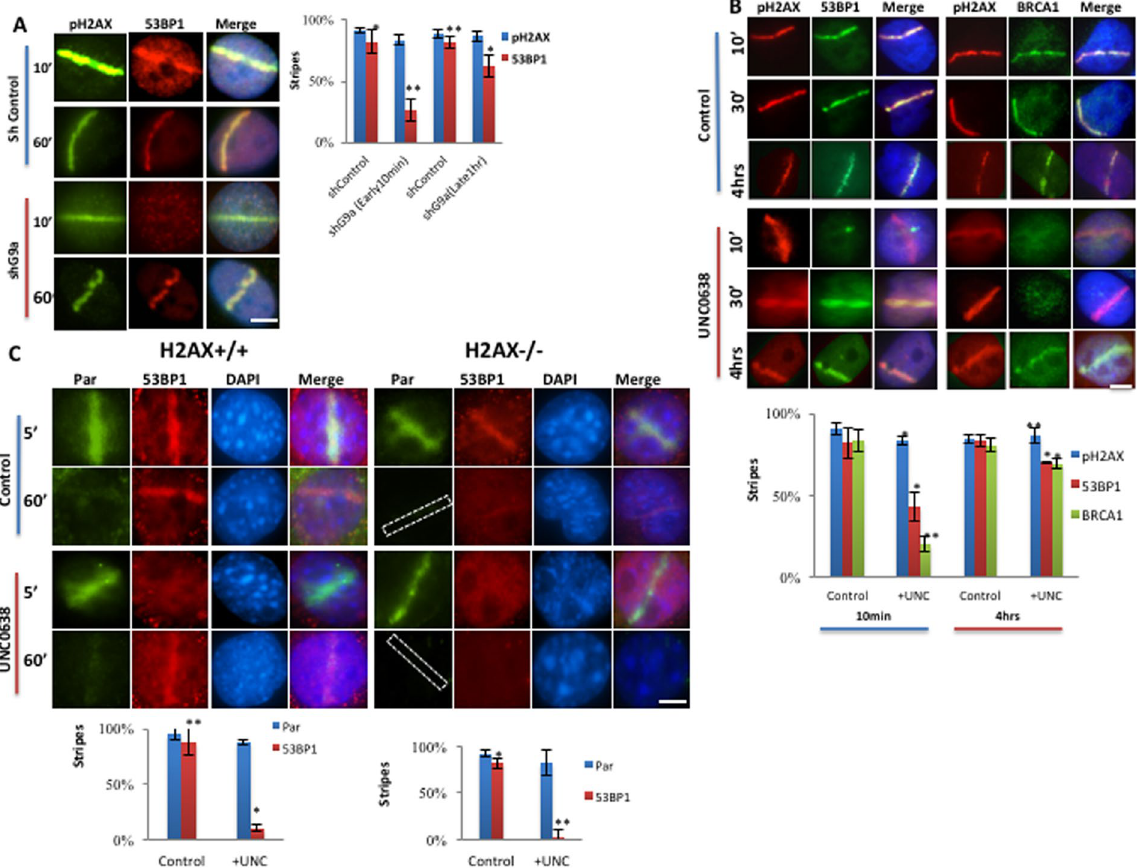
Figure 6. G9a is not required for late recruitment of 53BP1. ( A ) U2OS cells expressing control or shG9a were laser micro-irradiated and after indicated time points, analyzed by IF. Quantifications of results are shown on right. ( B ) U2OS cells were mock or UNC0638 treated, micro-irradiated and at indicted timepoints processed for IF using antibodies shown. Quantifications are shown at bottom. ( C ) H2AX − / − or wt MEFs were mock or UNC0638 treated, micro-irradiated, harvested at different time points, processed for IF and probed as indicated. Quantifications for 5 minute time-point are shown bottom of the images. Each point is the mean of at least three experiments ± the SEM. ** P < 0.01, * P < 0.05. Scale bar, 5 μ